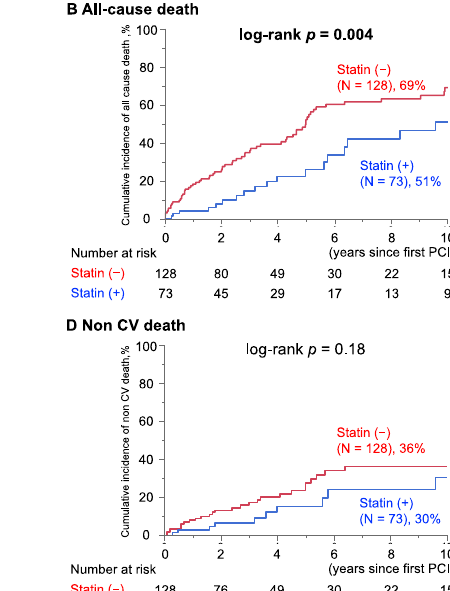
Figure 2. Cumulative cardiovascular event rates in groups divided by median LDL-C at procedure. Similar cumulative incidences of ( A ) CV death, ( B ) All-cause death, ( C ) 3P-MACE and ( D ) Non CV death in patients with and without LDL-C higher than median (>93 mg/dL). Percent indicates the cumulative incidence of events at 10 years of follow-up in each group.